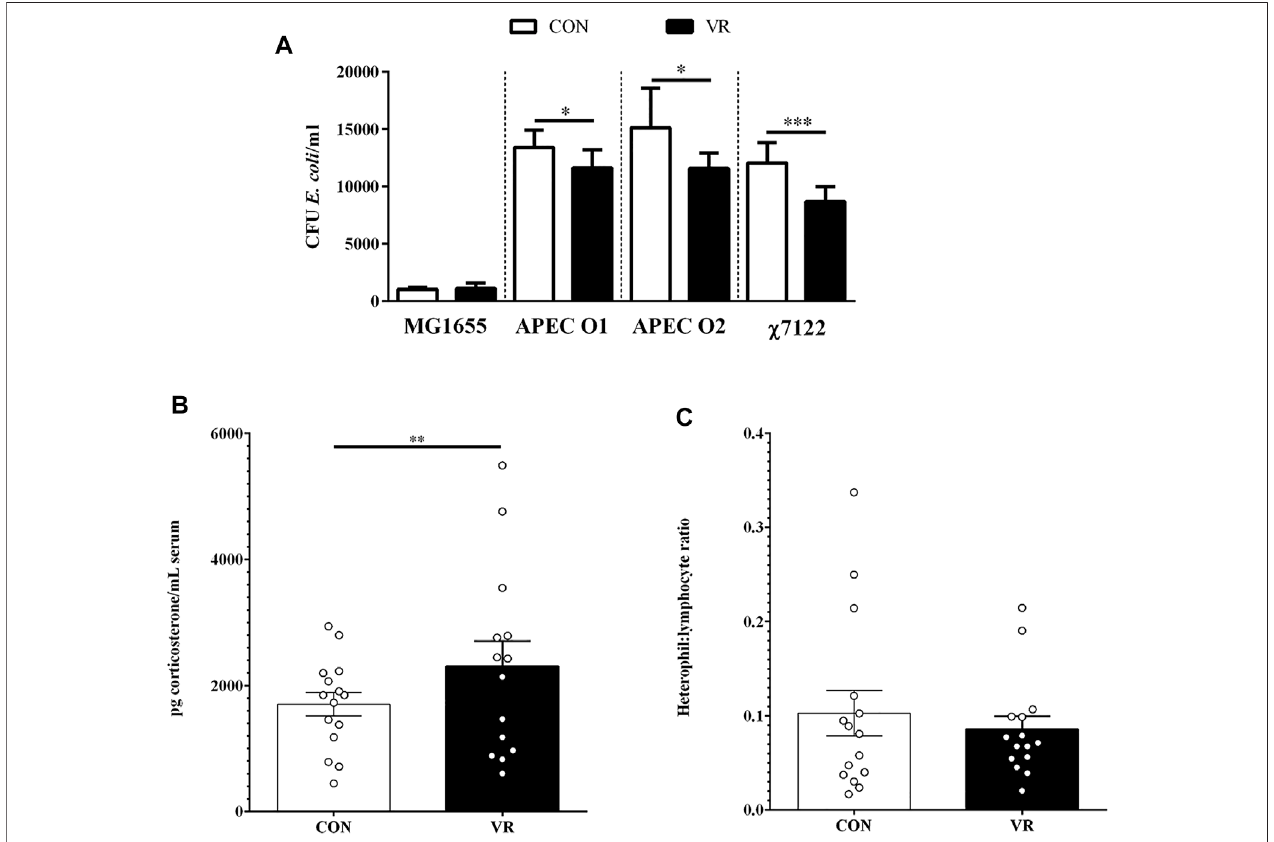
FIGURE 2 | Summary of data from chicken circulatory system (blood and plasma) ( n = 15/group). Differences in E. coli blood bactericidal responses in vitro (A) , plasma corticosterone levels (B) , and heterophil:lymphocyte ratios (C) were evaluated between CON and VR hens. * p < 0.05; ** p < 0.01; *** p < 0.001.